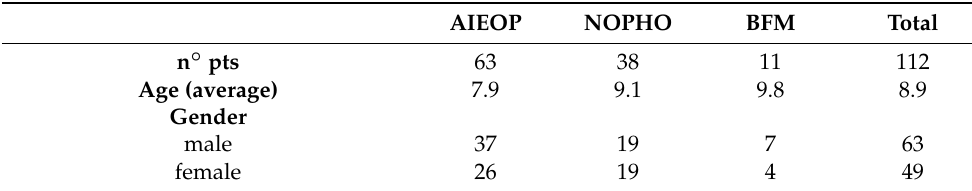
Table 1. Patients’